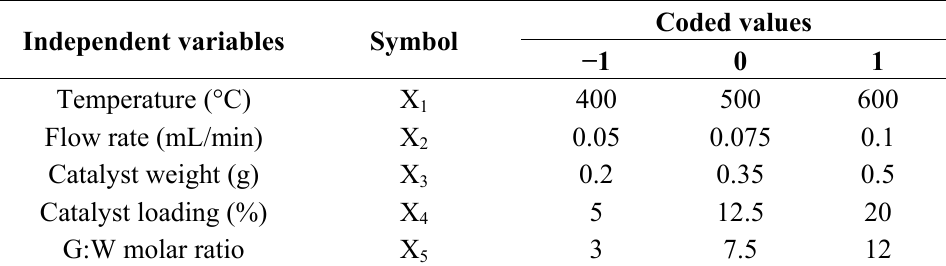
Table 1. Coded value of the independent variables.